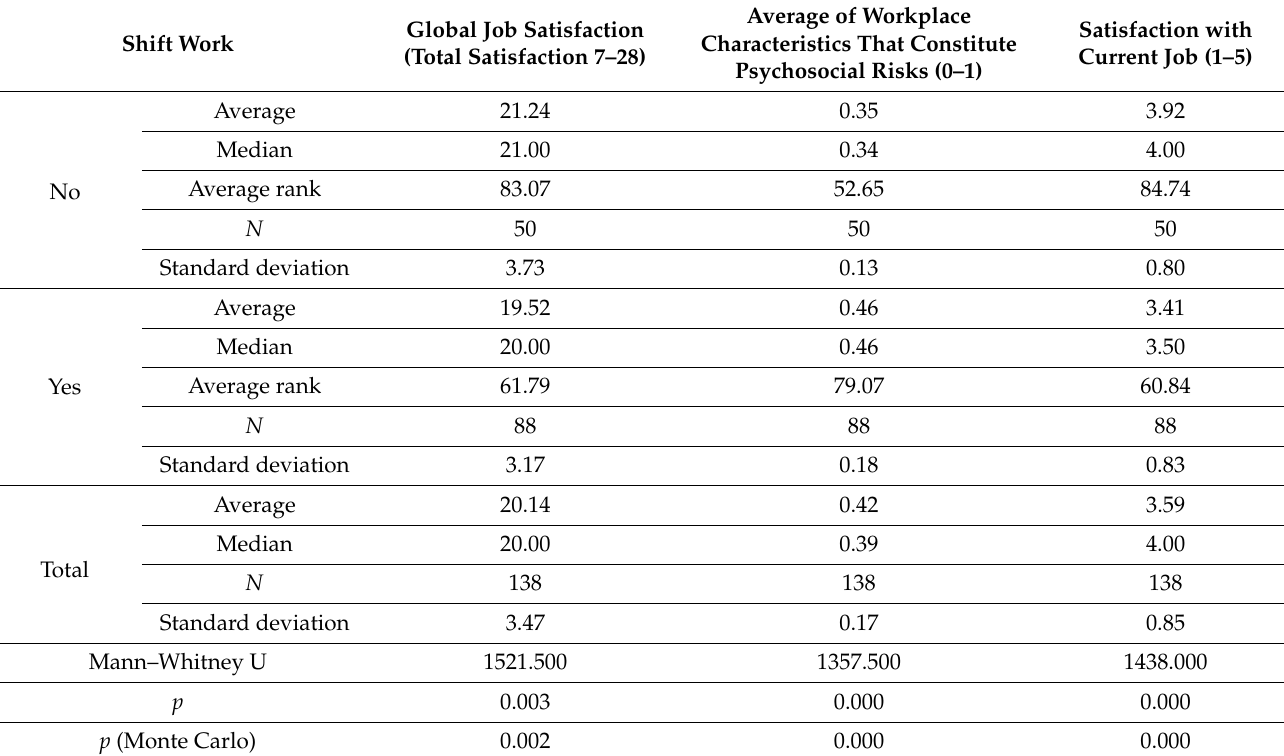
Table 5. Job characteristics constituting psychosocial risks and satisfaction levels of shift